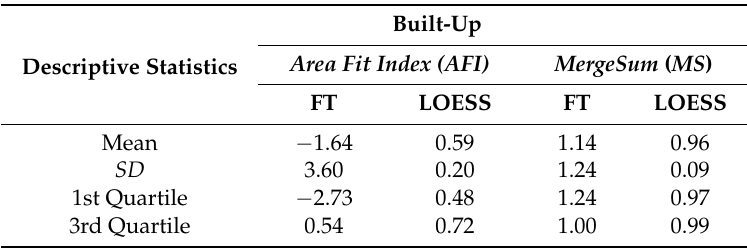
Table 3. Descriptive statistics for the Area Fit Index ( AFI ) and MergeSum ( MS ) metrics for the buildings category based on 20 reference objects.